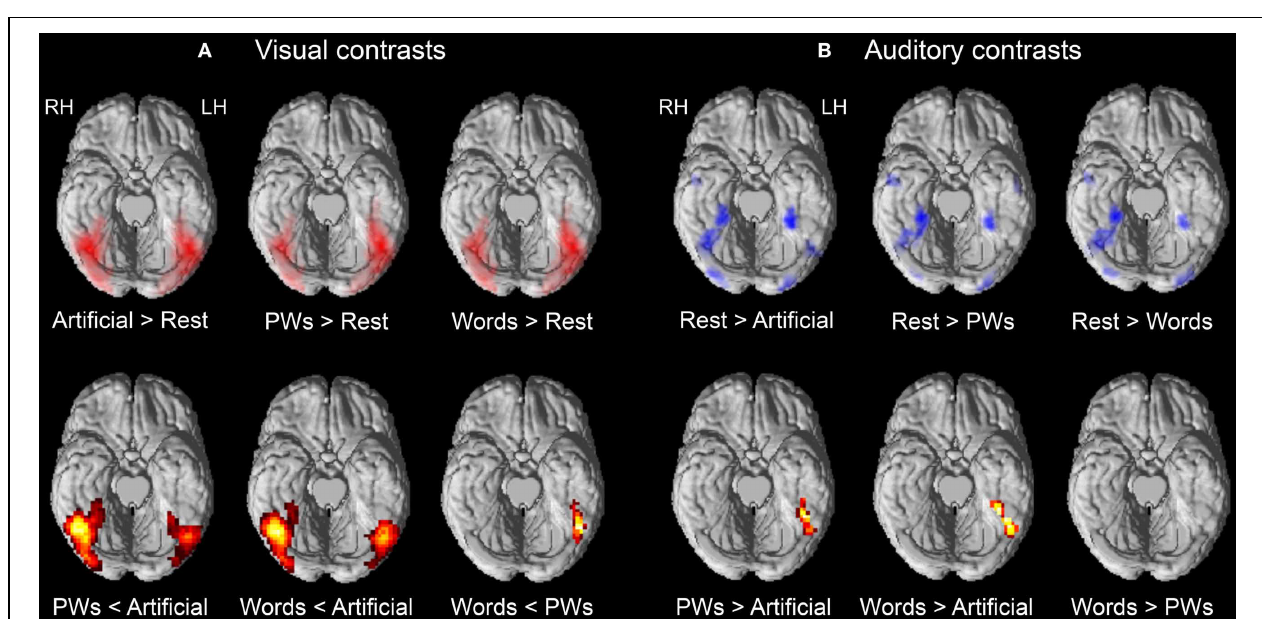
other. Activation maps are shown on the ventral surface of a rendered cortex. All contrasts are thresholded at p < 0 . 001 voxel-wise with a cluster extent threshold of p < 0 . 05 (FWE corrected). LH, left hemisphere; RH, right